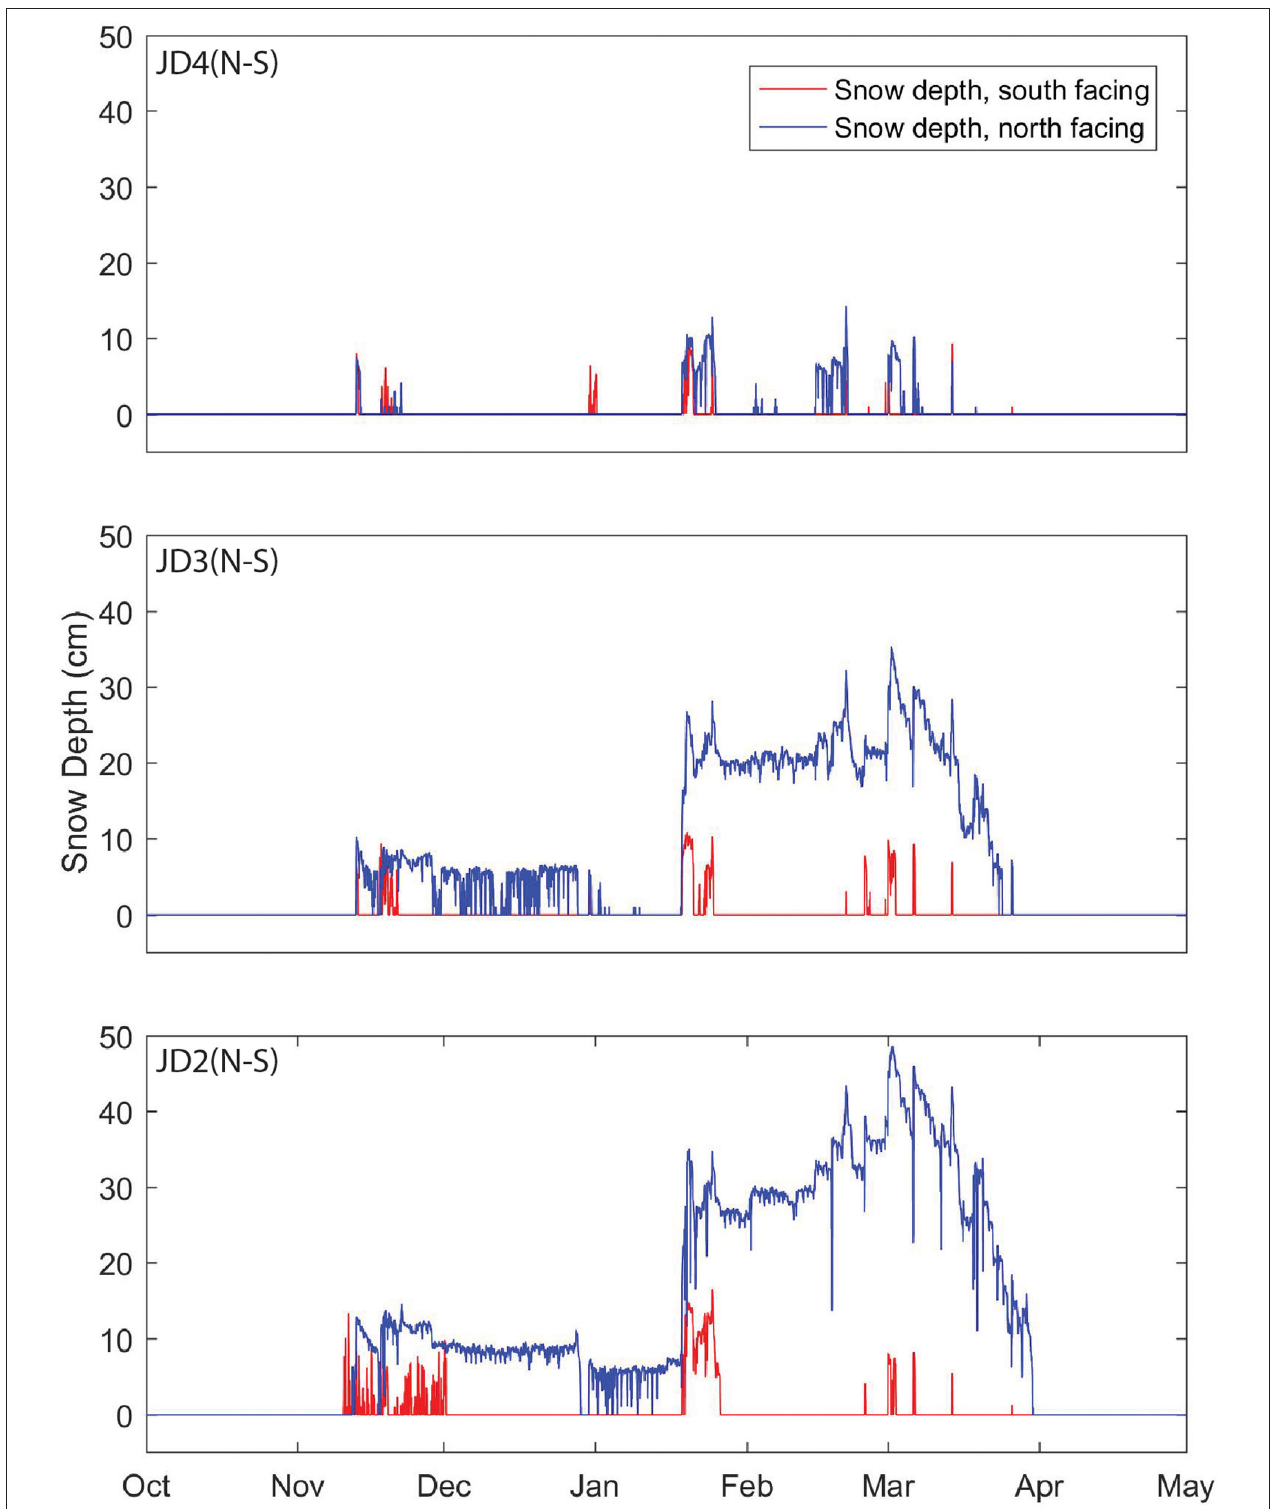
FIGURE 3 | Snow depth measured with acoustic sensors at the JD2(N–S), JD3(N–S), and JD4(N–S) instrument sites for the 2012 water year. The blue and red lines indicate the instruments on the north and south facing slopes, respectively. The amount of snow and time it covers the ground increases up drainage for both aspects, however the difference in snow accumulation between the aspects increases higher in the drainage.